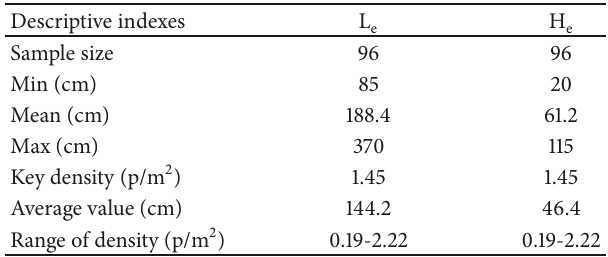
Table 4: Description of distance indicators on bidirectional stair-